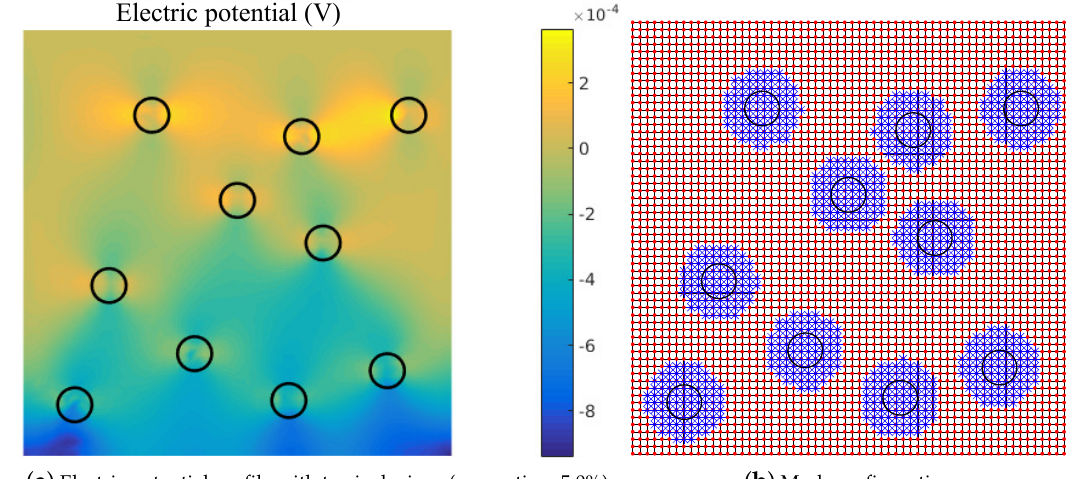
Figure 11. Calculation results of the square domain with randomly-distributed inclusions under compression: ( a ) electric potential profile for the domain with ten inclusions; ( b ) MLS discretization with the red solid point representing the nodes and the blue asterisk representing the enriched nodes.